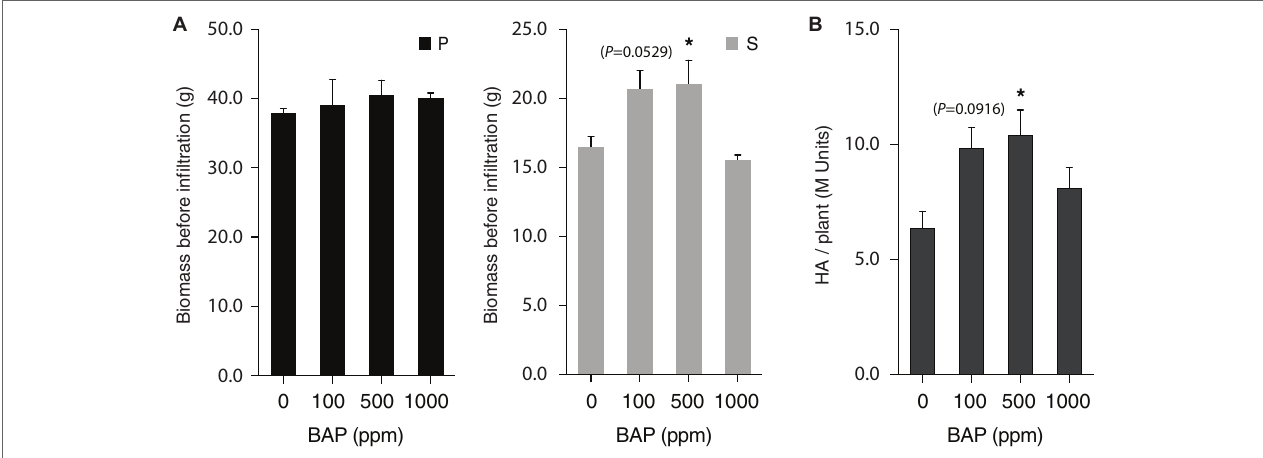
FIGURE 5 | 6-BAP cytokinin promotes axillary growth and total H1 yield per plant. Plants treated 7 days (100 and 500 ppm) or 12 days (1,000 ppm) after seedling transplantation and left to grow in greenhouse for an additional 13 or 8 days before vacuum infiltration for H1 expression in growth chamber. Harvested biomass was recorded (A) , and total H1 yield per plant determined (B) , for P and S leaf production units following heterologous protein expression. Each bar is the mean of three independent (replication) values ± se . Asterisks indicate statistically significant differences compared to the control treatment (post-ANOVA Tukey’s test; p < 0.05). P, production units P1–P3; S, production units